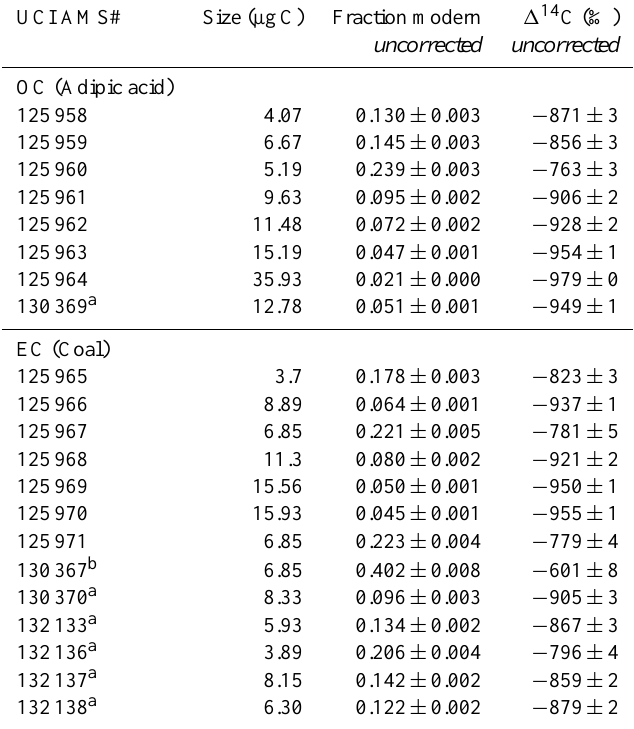
Table A2. Radiocarbon measurements of 14 C free materials (blanks). Following conventional AMS data reporting, blanks are not corrected for background